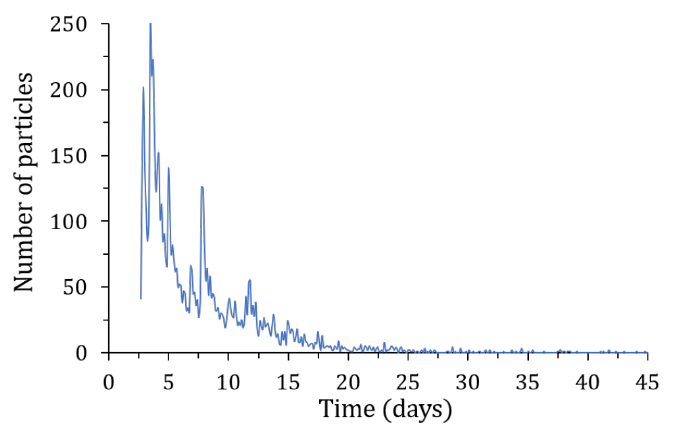
Figure 20. Residence time distribution of particles in the field injected at the beginning of the simulation.